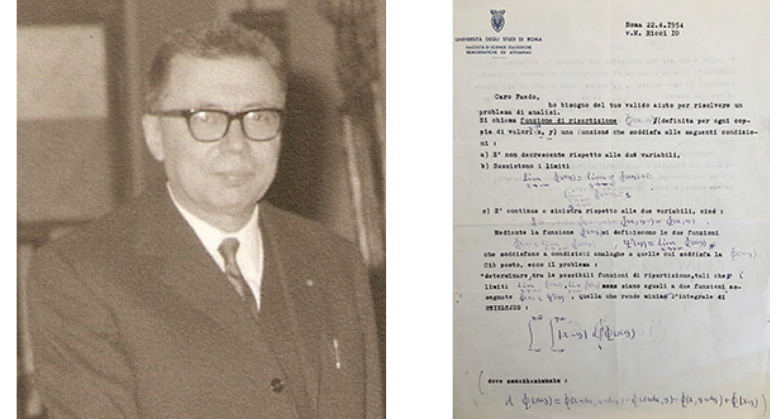
Figure 1: The letter by which Giuseppe Pompilj (on the left) asked Alesandro Faedo about the solution of problem (1)